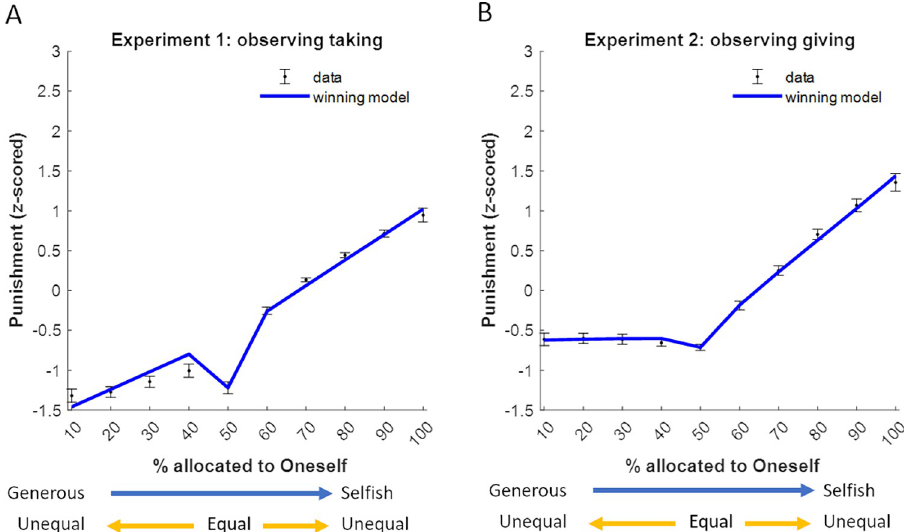
Fig 8. Observers’ punishment decisions reflect selfishness aversion and inequality aversion. Plotted are the winning models fit at the group-level for Experiment 1 ( A ; Punishment ¼ (cid:0) 1 : 93 þ 2 : 54 Selfishness þ 0 : 25 Inequality þ 0 : 30 Selfishness � Endowment (cid:0) 0 : 64 even split ; left panel) and Experiment 2 ( B ; Punishment ¼ (cid:0) 1 : 6 þ 1 : 69 Selfishness þ 0 : 99 Inequality þ 0 : 68 Selfishness � Endowment (cid:0) 0 : 12 even split ; right panel). Participants’ punishment choices were z-scored before model-fitting to standardize responses. The predicted punishment from the model (purple line) is overlaid on the mean observed punishment over all participants (purple dots). Error bars represent